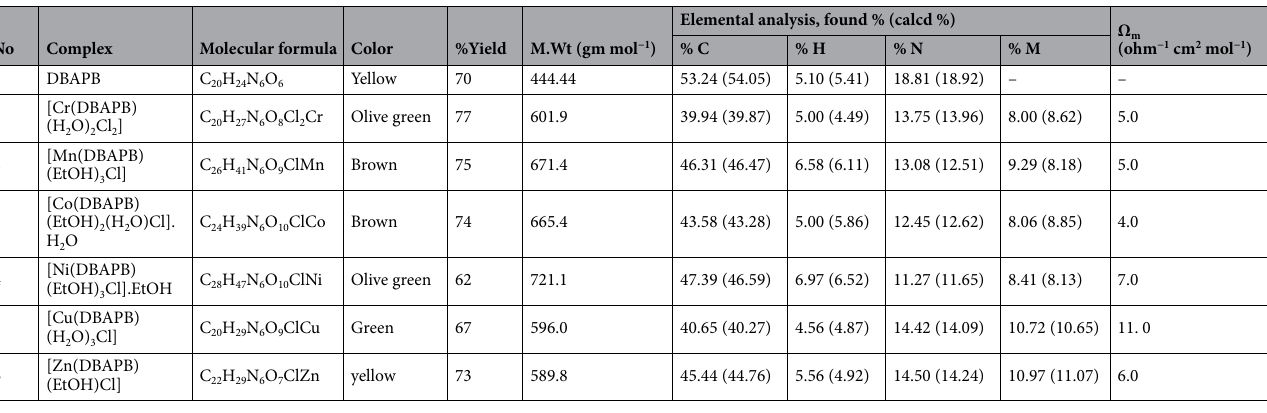
Table 1. Physicochemical properties of the metal complexes of the Schiff base ligand,